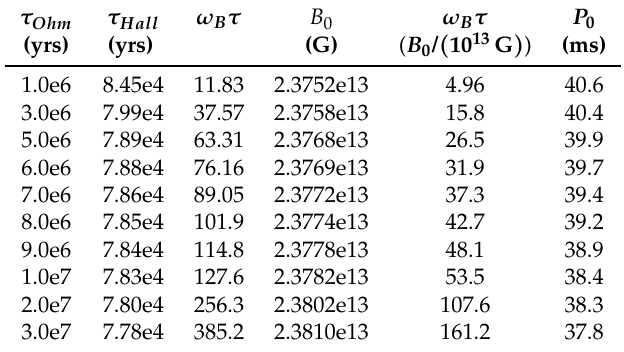
Table 6. Partial fitted values of Ohmic dissipation timescale, Hall drift timescale, magnetization parameter, initial dipole magnetic field, and initial rotational period of PSR J 1640-4631.